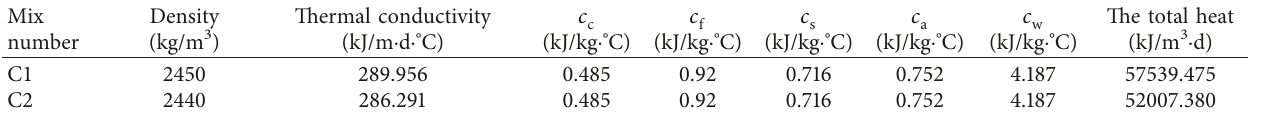
Table 5: The thermal parameters involved in Method 2.